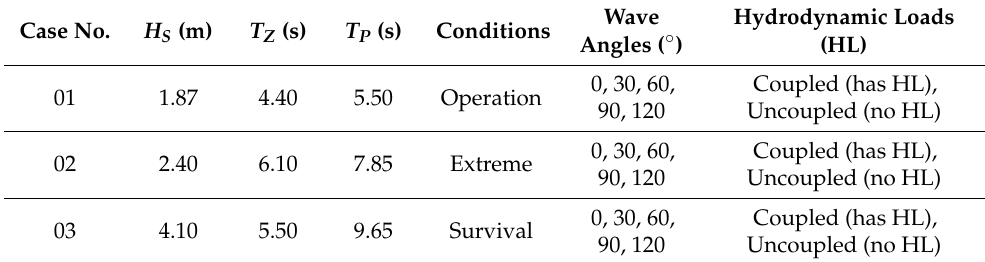
Table 8. Wave parameters for the three load cases. Case